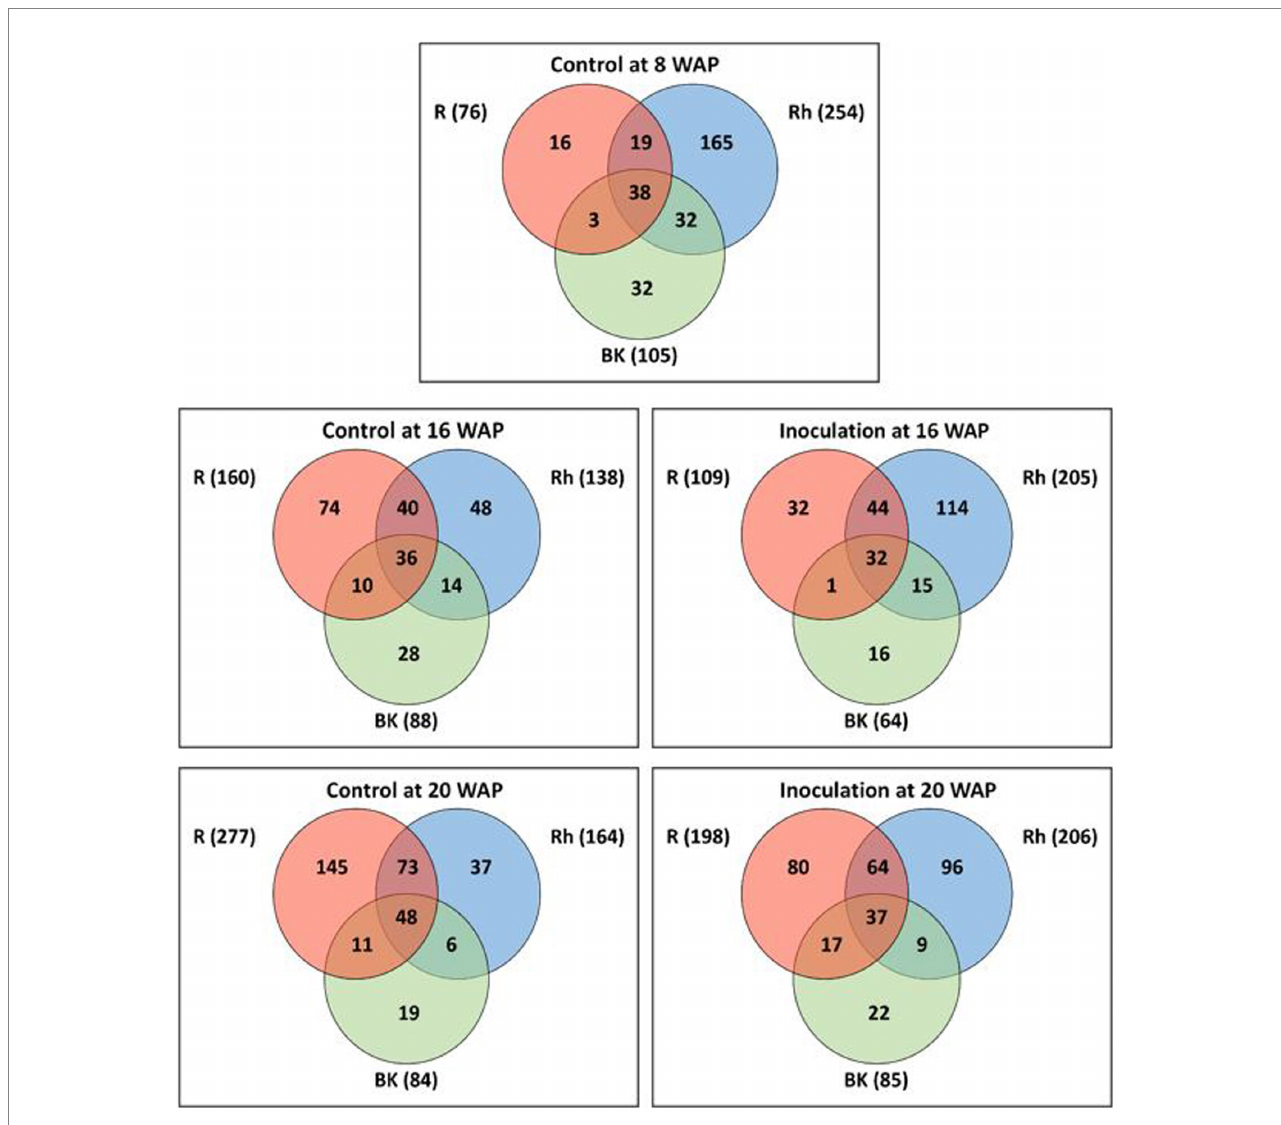
FIGURE 1 Venn diagrams showing the overlap between amplicon sequence variants (ASVs) under each treatment at 8 (pre-inoculation), 16, and 20 weeks after planting (WAP). Numbers in the brackets represent the total number of ASVs in the root (R), rhizosphere (Rh), and bulk soil (BK) samples under each treatment at each time